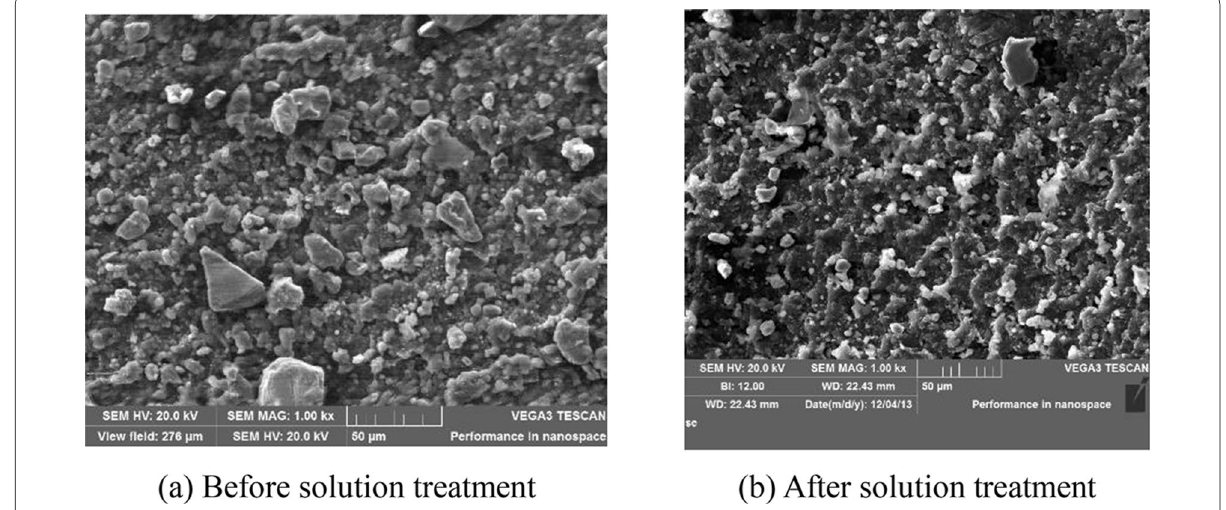
Fig. 9 Effect of RP pretreatment methods on the compressive